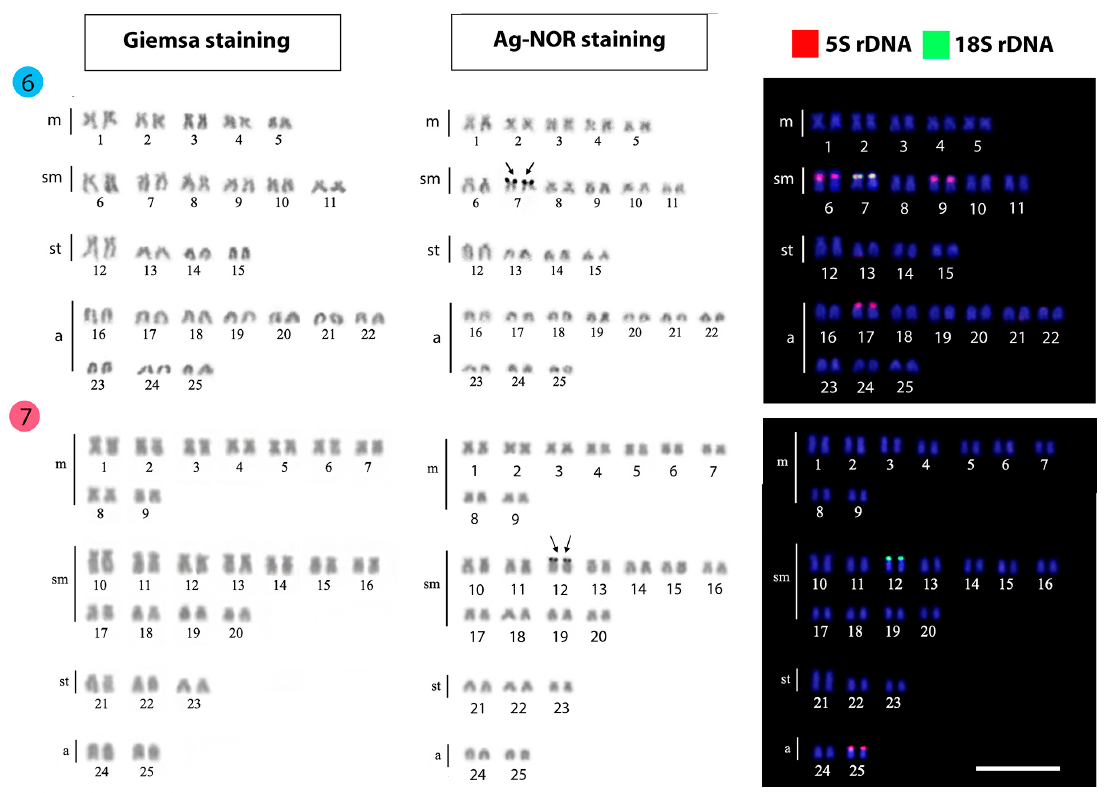
Figure 4. Karyotypes of ‘ poropuntiinae ’ species arranged from Giemsa-stained, Ag-NOR banding chromosomes (arrows) and chromosomes after FISH with 5S (red) and 18S (green) rDNA probes: 6 = M. ectypus ; 7 = P. proctozystron . Chromosomes were counterstained with DAPI (blue). Scale bar = 5 µm.